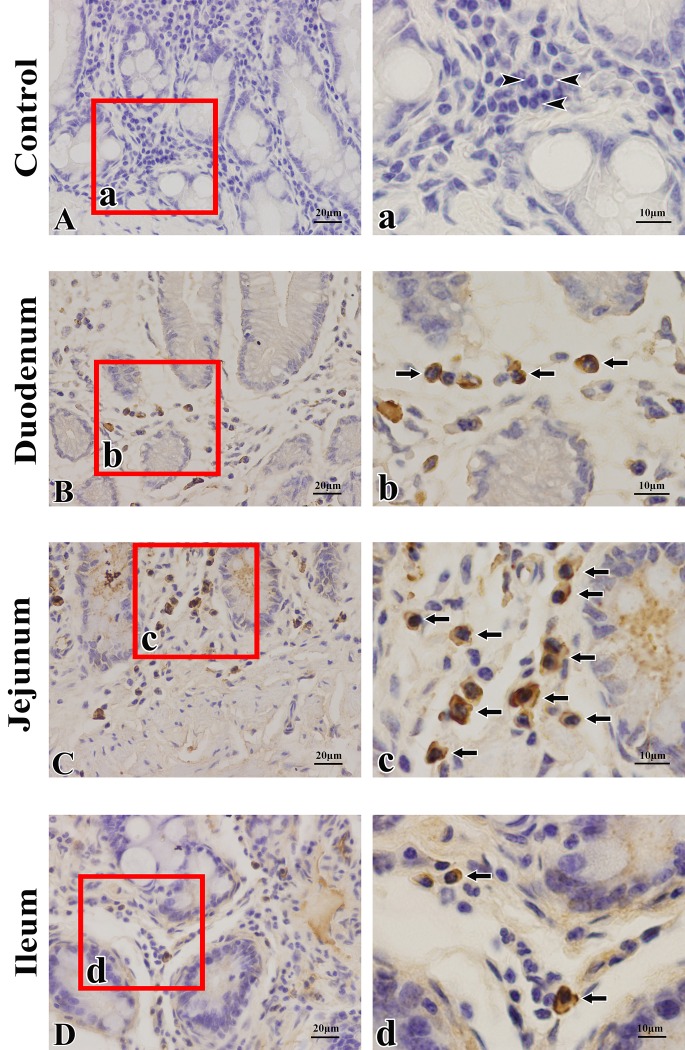
Immunohistochemical staining of IgG antibody-secreting cells in the small intestines of young Bactrian camels.(A) Negative control (lamina propria (LP) of the jejunum, with triangles indicating plasma cells). (B) Distribution of IgG antibody-secreting cells (ASCs) in the duodenal LP. (C) Distribution of IgG ASCs in the jejunal LP. (D) Distribution of IgG ASCs in the ileal LP. IgG ASCs were scattered in the LP of the small intestine, and some cells aggregated around the crypts. Arrows indicate IgG ASCs. Small pictures (a-d) are representative views from the four sublocations (original magnification: left column = 400×, right column = 1000×).